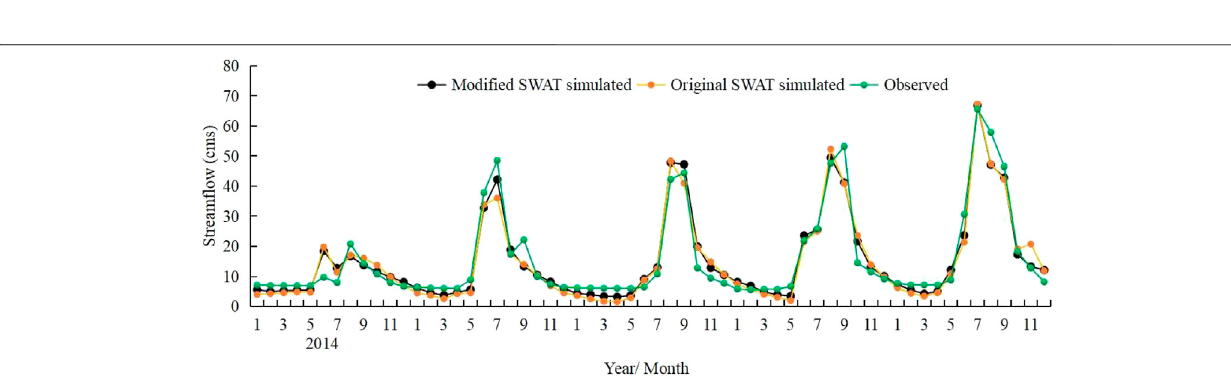
Frontiers in Environmental Science |